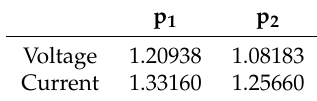
Table 3. Parameters obtained from the minimization